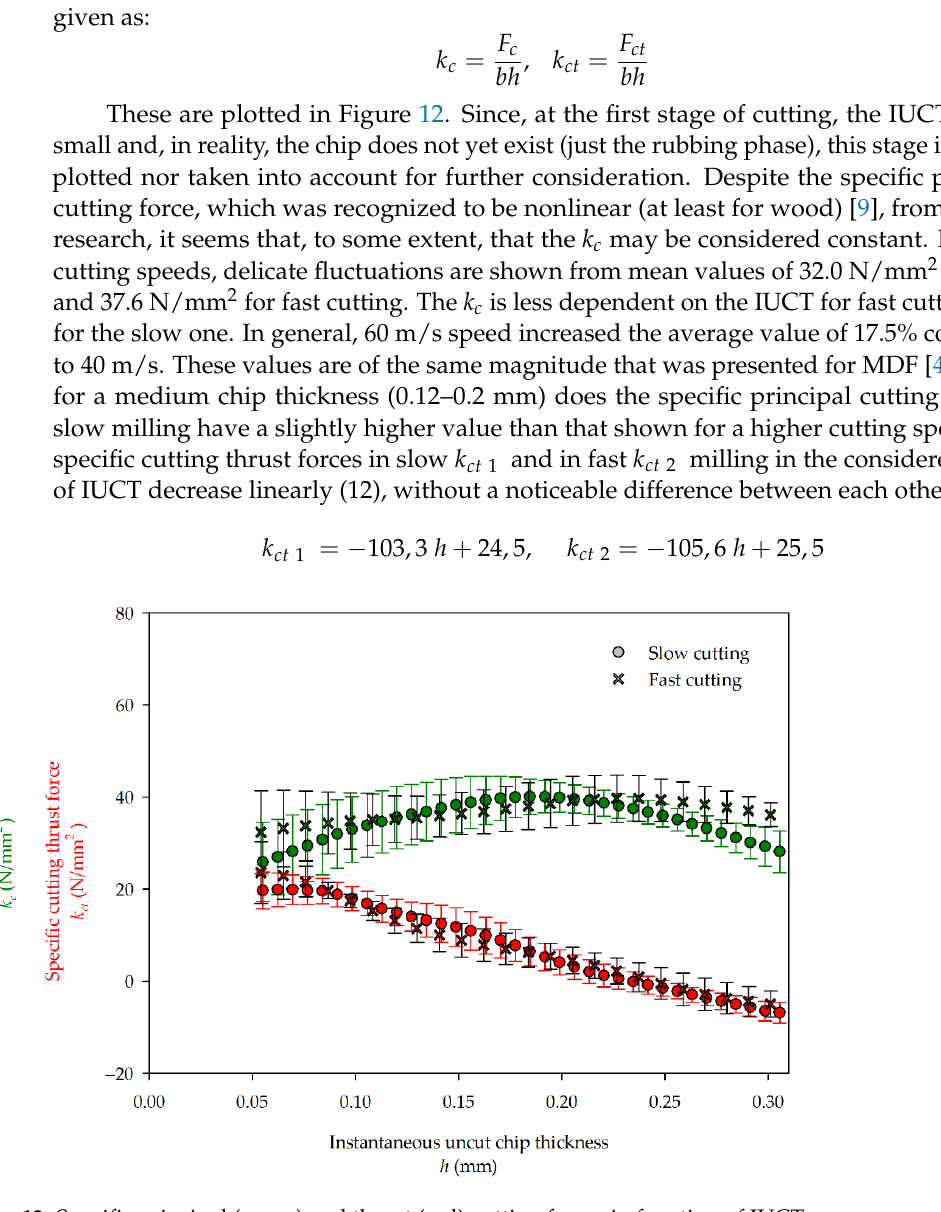
Figure 12. Specific principal (green) and thrust (red) cutting forces in function of IUCT.